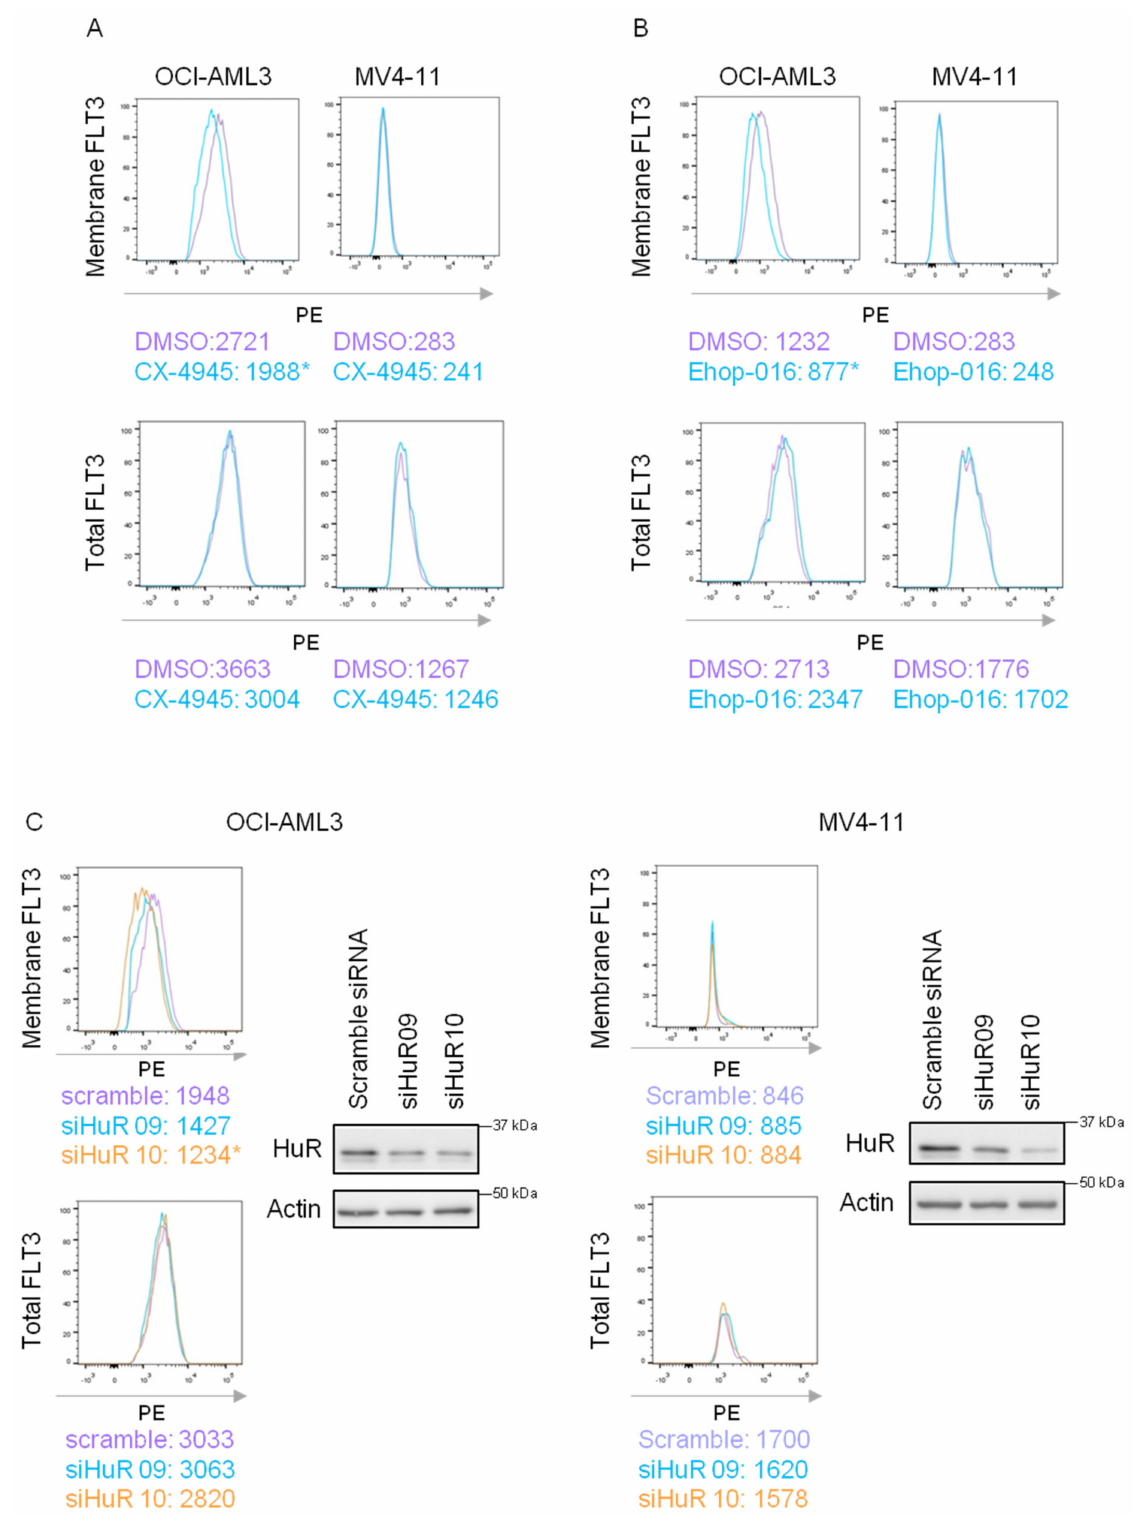
Figure 3. HuR/SET/RAC1 complex regulates FLT3 membrane translocation. ( A ) AML cells OCI- AML3 (FLT3-WT) and MV4-11 (FLT3-ITD) were treated with the CK2 inhibitor CX-4945 (5 µ M, 24 h). FACS analysis of membrane FLT3 in non-permeabilized and total FLT3 in permeabilized cells showed a decrease in membrane FLT3, without changes in total FLT3, after CK2 inhibition due to SET nuclear retention in FLT3-WT. This was not observed in FLT3-ITD. Numbers represent mean PE fluorescence intensity. Representative image from more than 6 experiments is shown. ( B ) AML